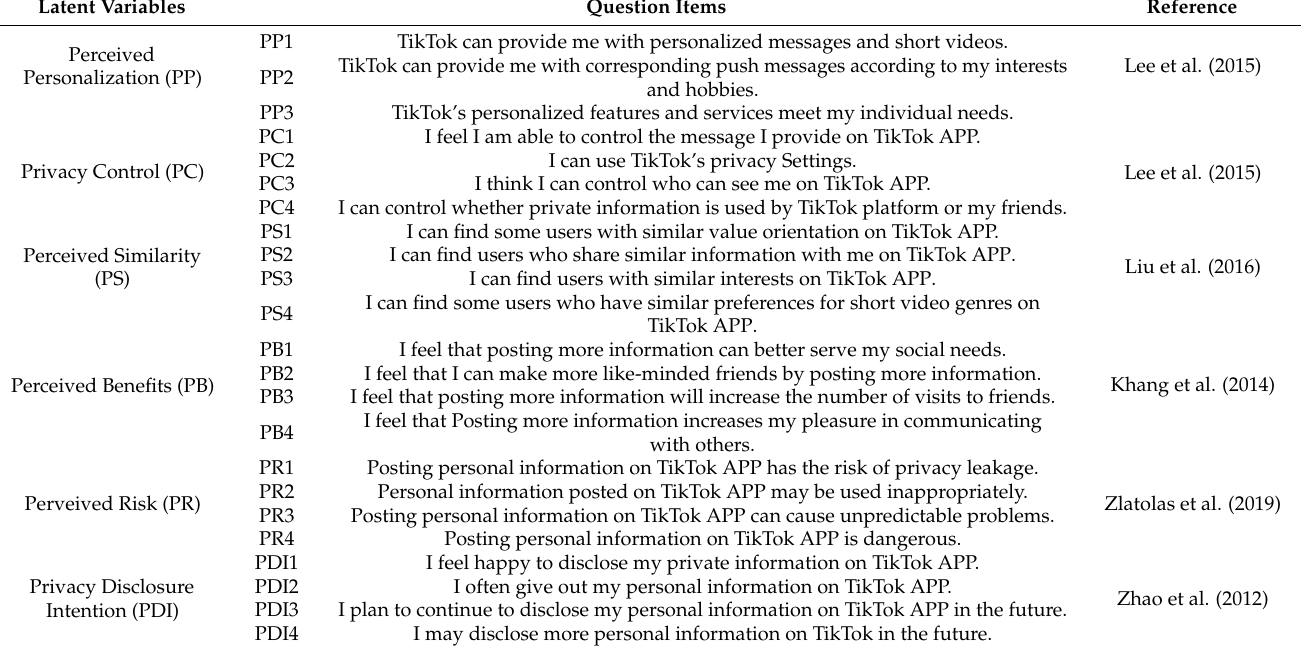
Table A1. Our questionnaire design is as